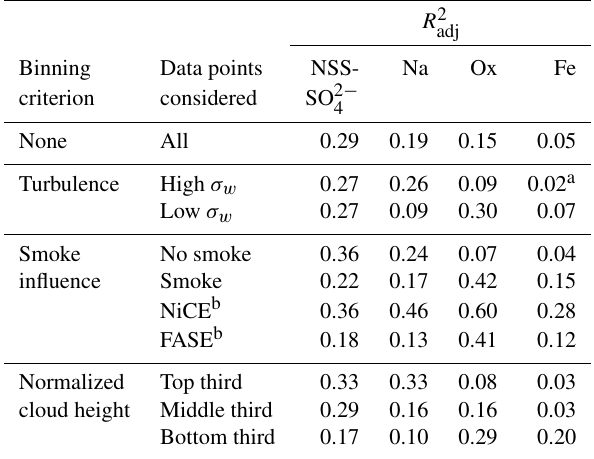
Table 8. Summary of the R 2 obtained when correlating mass con- adj centration of a species to N d under different atmospheric condi- tions.